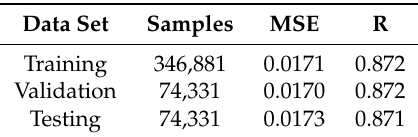
Table 3. Developed neural network (NN) model performance measures for the training, validation, and testing data